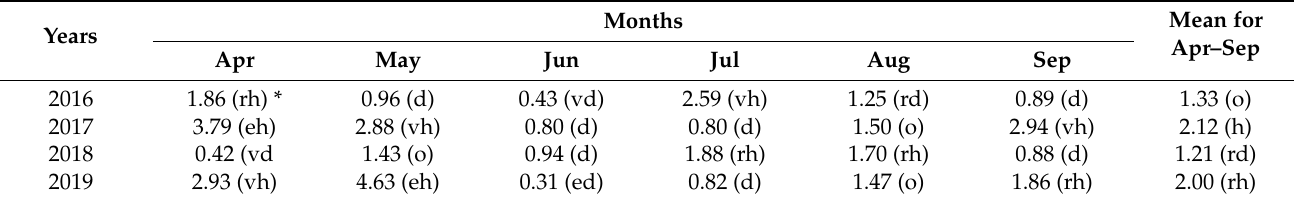
Table 1. The hydrothermal index (K) during the growing season of soybean.